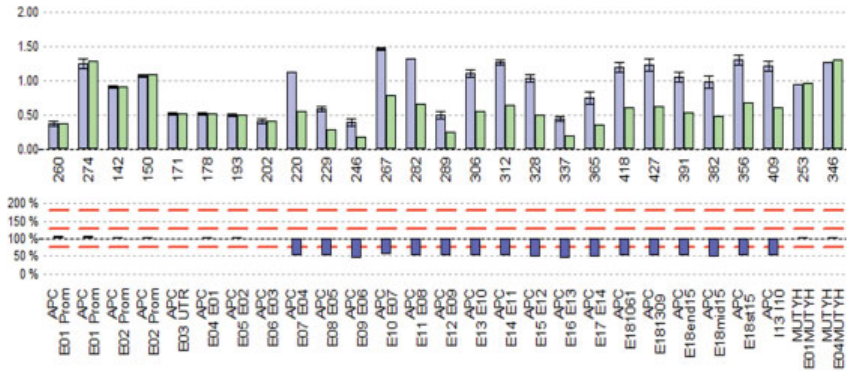
Fig. 4 Deletion/duplication analysis using multiplex ligation-dependent probe ampli fi cation showing monoallelic deletion affecting most of the APC coding region, showing that the gene dose of exon 4 onwards is reduced by 50% and proving the heterozygous deletion of a large portion of APC .